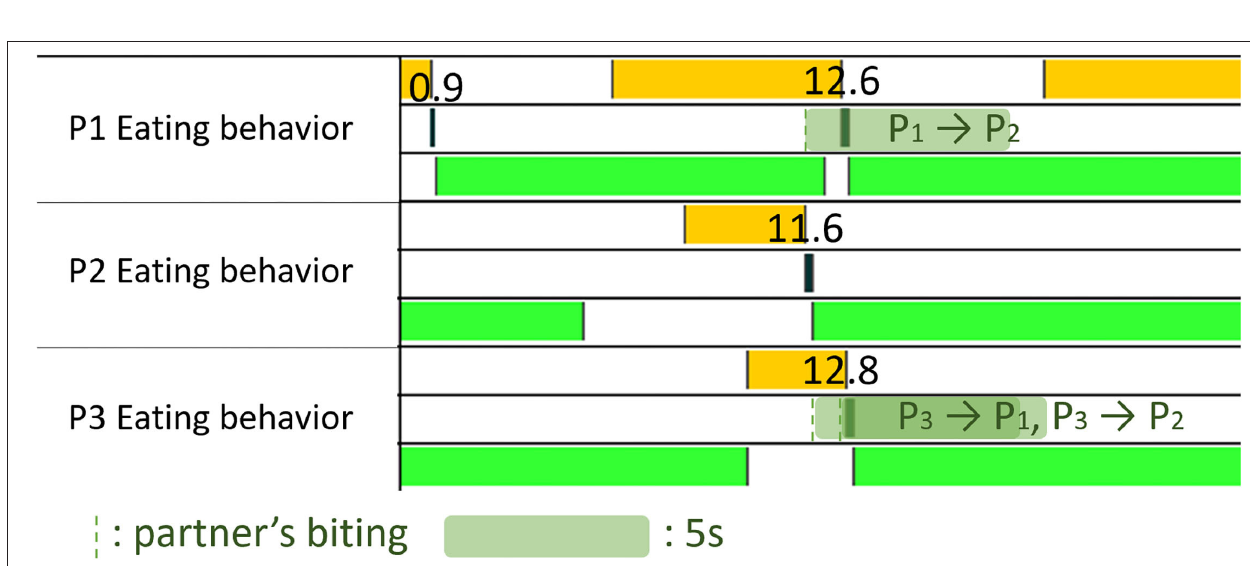
FIGURE 2 | Timeline of eating actions. The average time the participants spent holding food per bite (HfpB) was the total holding food time divided by the number of bites.